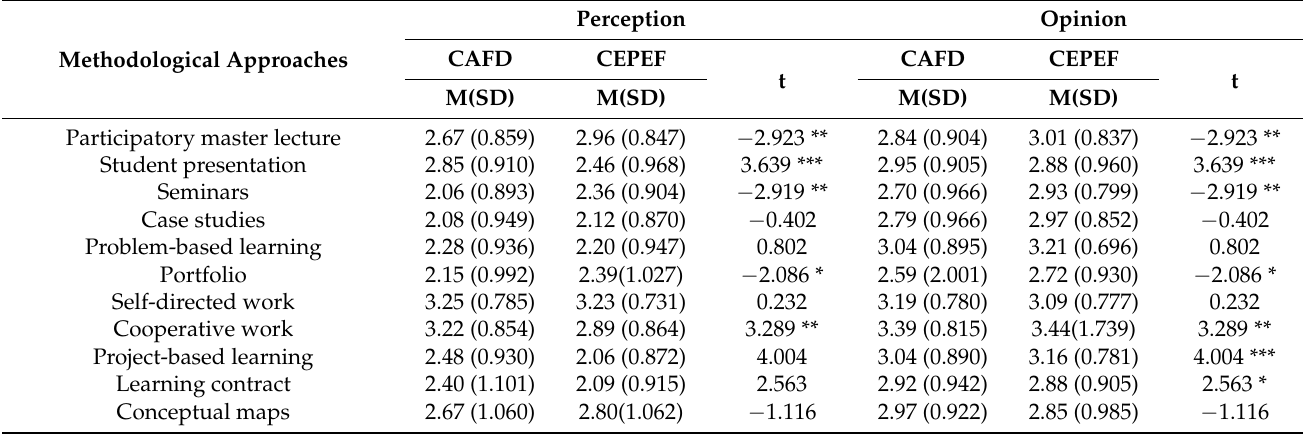
Table 4. Comparison of the perception and opinion on the methodological approaches as a function of degree studied.